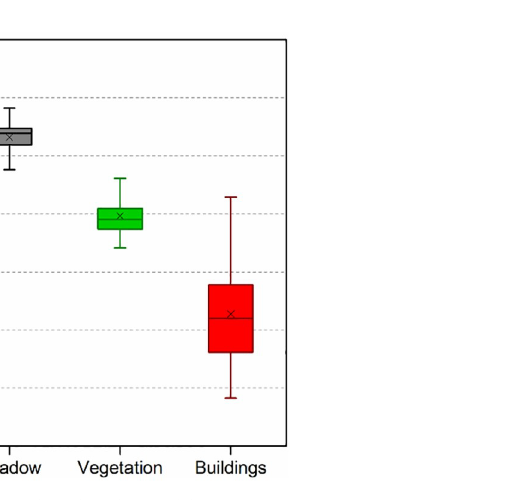
Fig 4. K-T transformation wetness component boxplot of typical